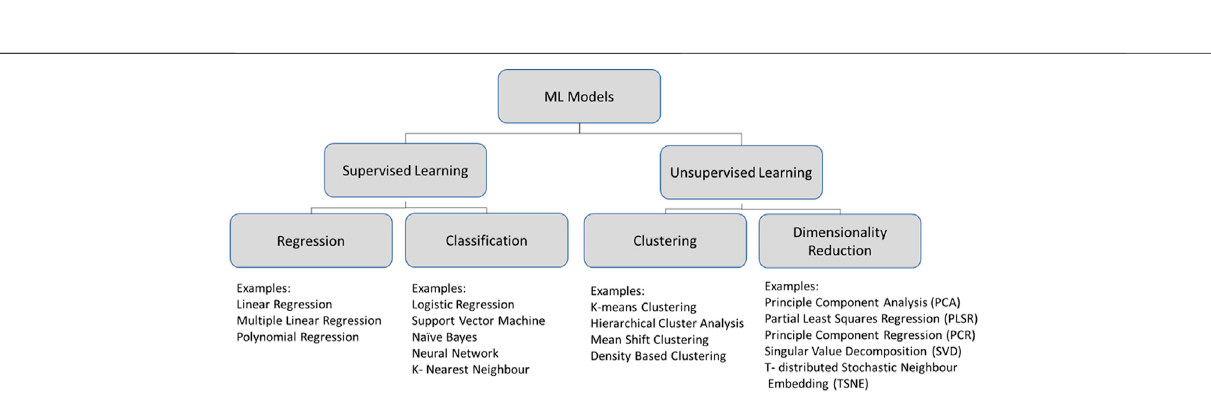
Frontiers in Astronomy and Space Sciences |